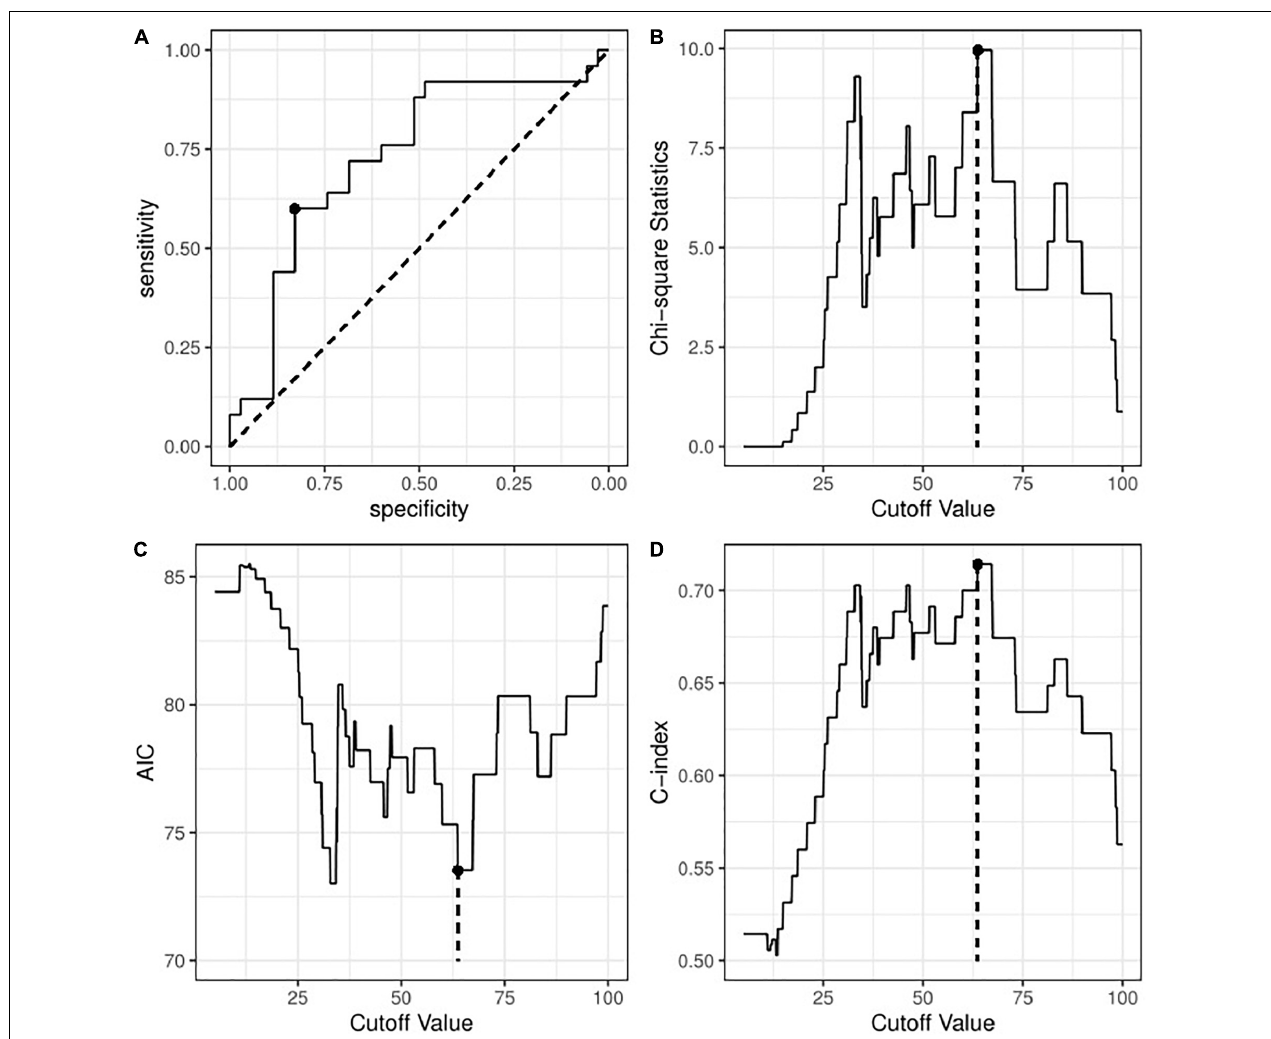
FIGURE 2 | Identification of optimal cut-off value for peak TBIL based on (A) the receiver operating curve method; (B) Chi-square test with maximum statistics; (C) logistic regression with minimum AIC; or (D) logistic regression with maximum C-index. TBIL, total bilirubin; AIC, Akaike information criterion; C-index, concordance